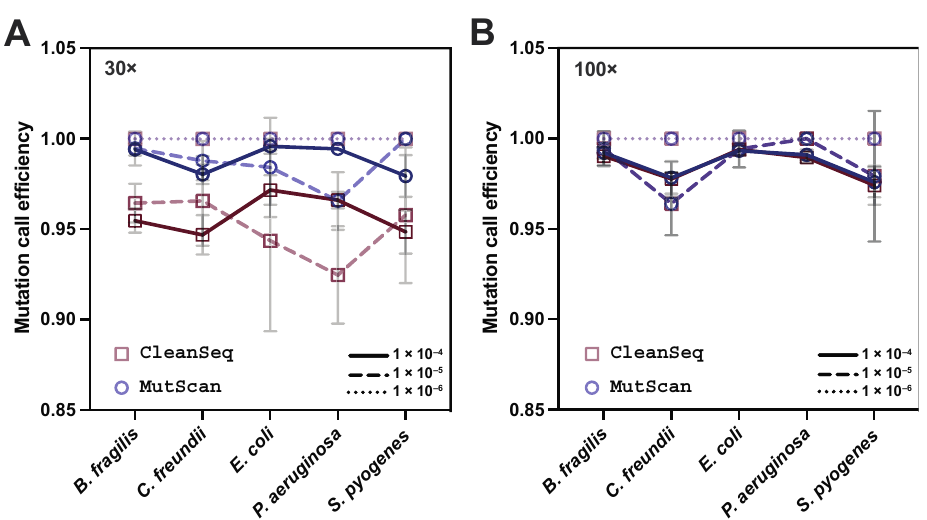
Figure 3. Comparison of the mutation calling performance between CleanSeq and MutScan. The simulated datasets of five kinds of bacterial species ( P. aeruginosa (CP007224.1), E. coli (NZ_LR881938.1), Citrobacter freundii (CP016762.1), B. fragilis (CR626927.1) and Streptococcus pyogenes (AE014074.1)) with different sequencing coverage (( A ), 30 × ; ( B ), 100 × ) and mutation rates (1 × 10 − 4 , 1 × 10 − 5 , and 1 × 10 − 6 ) were used to test the efficiency of mutation calling and verification.